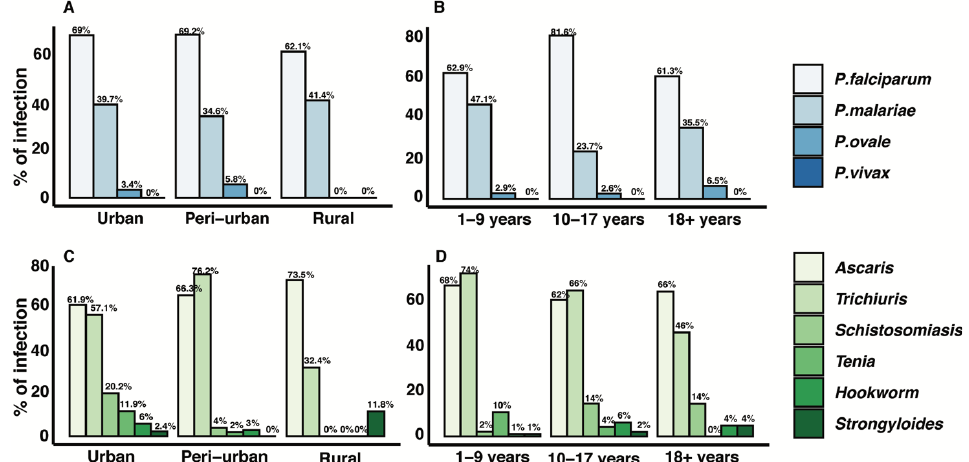
Figure 1. Distribution of malaria infection ( top row) and helminth ( bottom row). Panel A is the distribution of plasmodium by area and panel B is by age. Panel C is the distribution of helminth by area and panel D is by age.